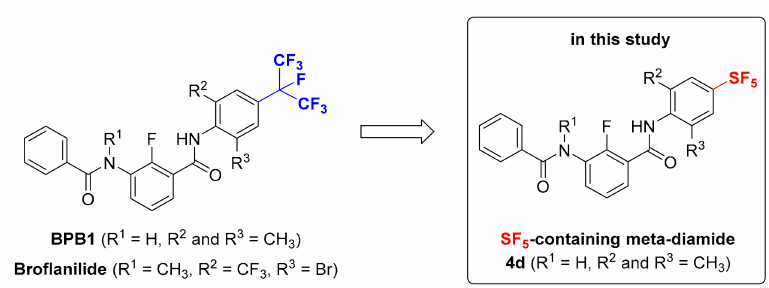
Figure 2. SF 5 -containing meta-diamide insecticides in this